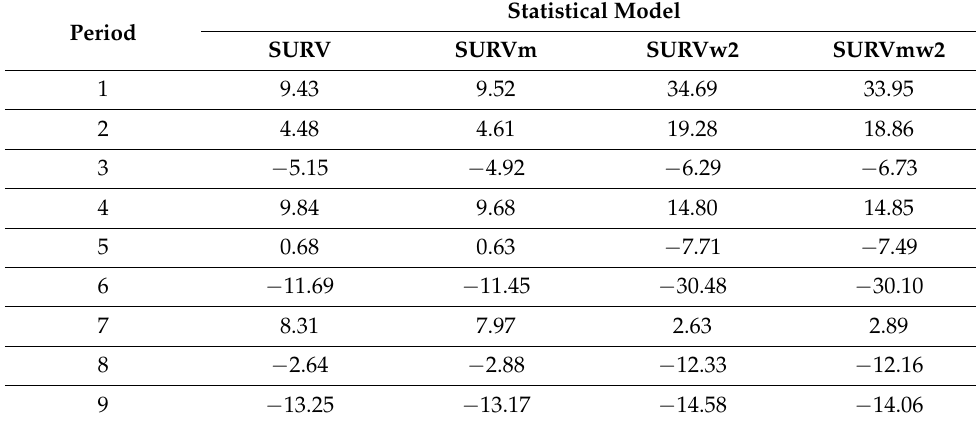
Table 6. REML solution for period